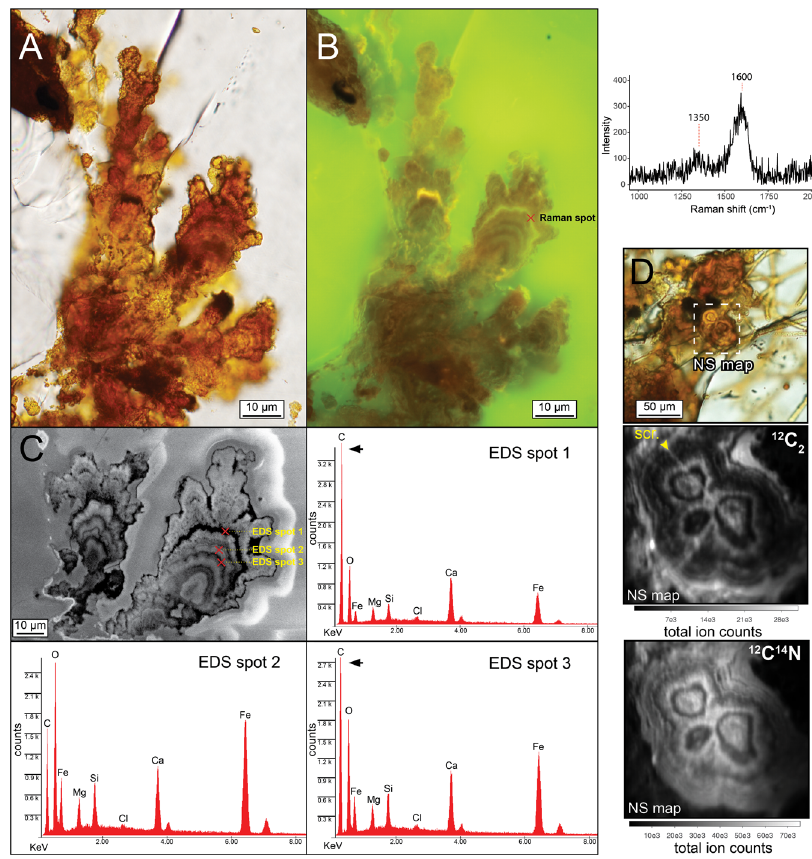
Fig. 4 Frutexites -like microstromatolitic structures and associated compositional maps. A Branching columnar structures display feint lamination under plane-polarized light. B Fluorescence microscopy reveals fi ne laminations in greater detail. Raman spectroscopic analysis of laminae show the presence of “ D ” and “ G ” vibrational bands at ~1350 cm − 1 and ~1600 cm − 1 respectively (shown at right), indicative of macromolecular carbonaceous material. C SEM secondary electron image shows microscale laminations and marks the locations of EDS spot analyses. EDS measurements show alternation between dark C-rich laminae (e.g., spot 1 & 3), and bright laminae dominantly composed of O, C, Ca, Fe, Si, and Mg (e.g., spot 2). D location of NanoSIMS mapping conducted on microstromatolites cut orthogonal to the growth direction by thin sectioning. Bottom panels of ( D ) show laminae containing nitrogen and carbon. A yellow arrow marks a surface scratch that appears in the 12 C 2 ion map introduced during sample preparation. Brighter features in both NanoSIMS images correspond to higher total ion counts per